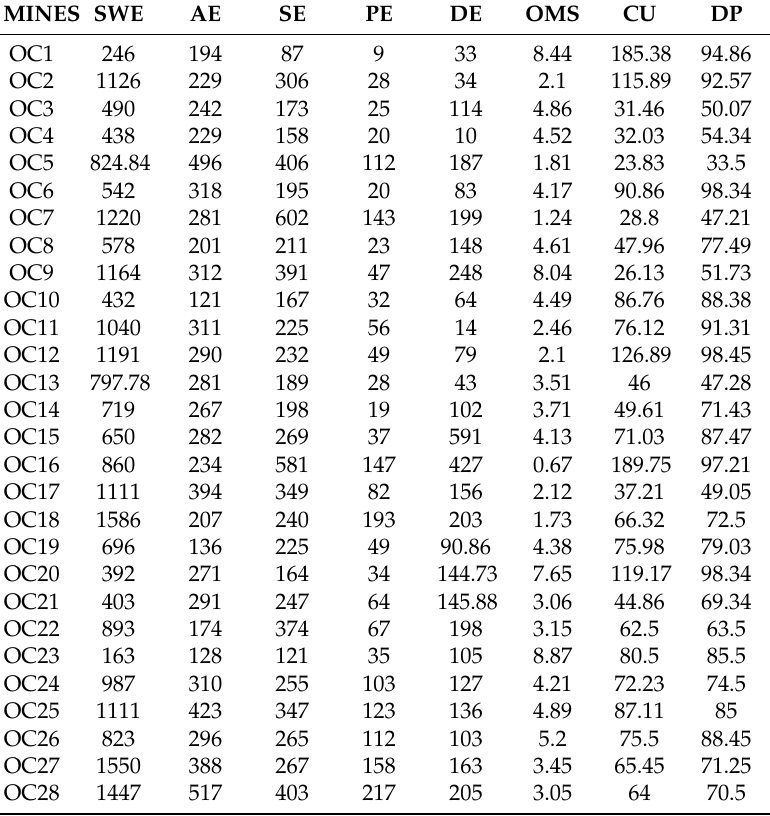
Table A2. Opencast Mines Data for 2017–2018.